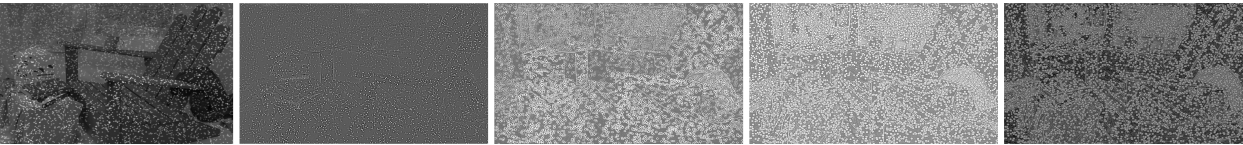
Figure 4. The figures show the filtered images used for combinations for the experiment. From left to right, the figures show images with no filter, the mean filter, the LoG filter, the BilSub filter, and the rank filter applied. For visualization, contrasts of all images have been enhanced through histogram